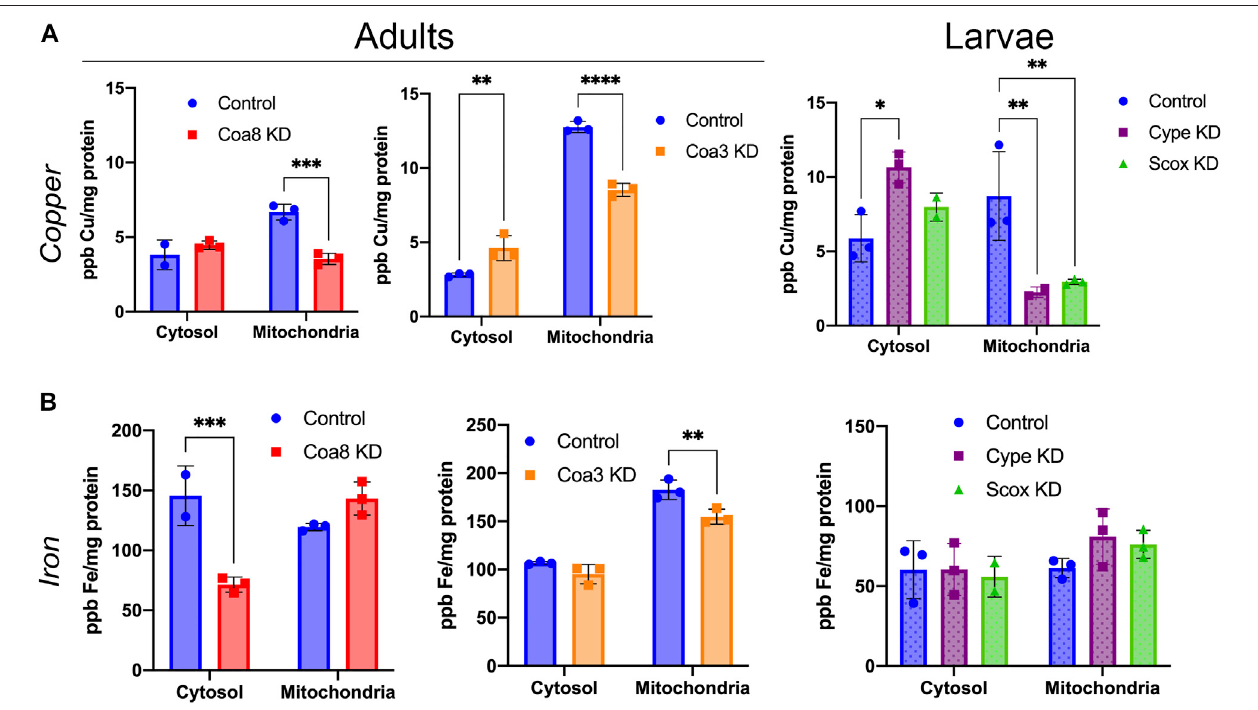
FIGURE 2 | Cellular copper and iron compartmentalization in D. melanogaster models of COX de fi ciency. (A) Copper and (B) iron content in parts per billion (ppb) and normalized by protein content (mg protein) in cytosolic and mitochondrial fractions from control adults (solid blue bars), Coa8 KD adults (solid red bars), Coa3 KD adults (solid orange bars), control larvae (dotted blue bars), cype KD larvae (dotted purple bars) and Scox KD larvae (dotted green bars). The symbols represent the individual values of each replicate measurement, and the bars represent the mean ± SD. The statistical signi fi cance was calculated using two-way ANOVA